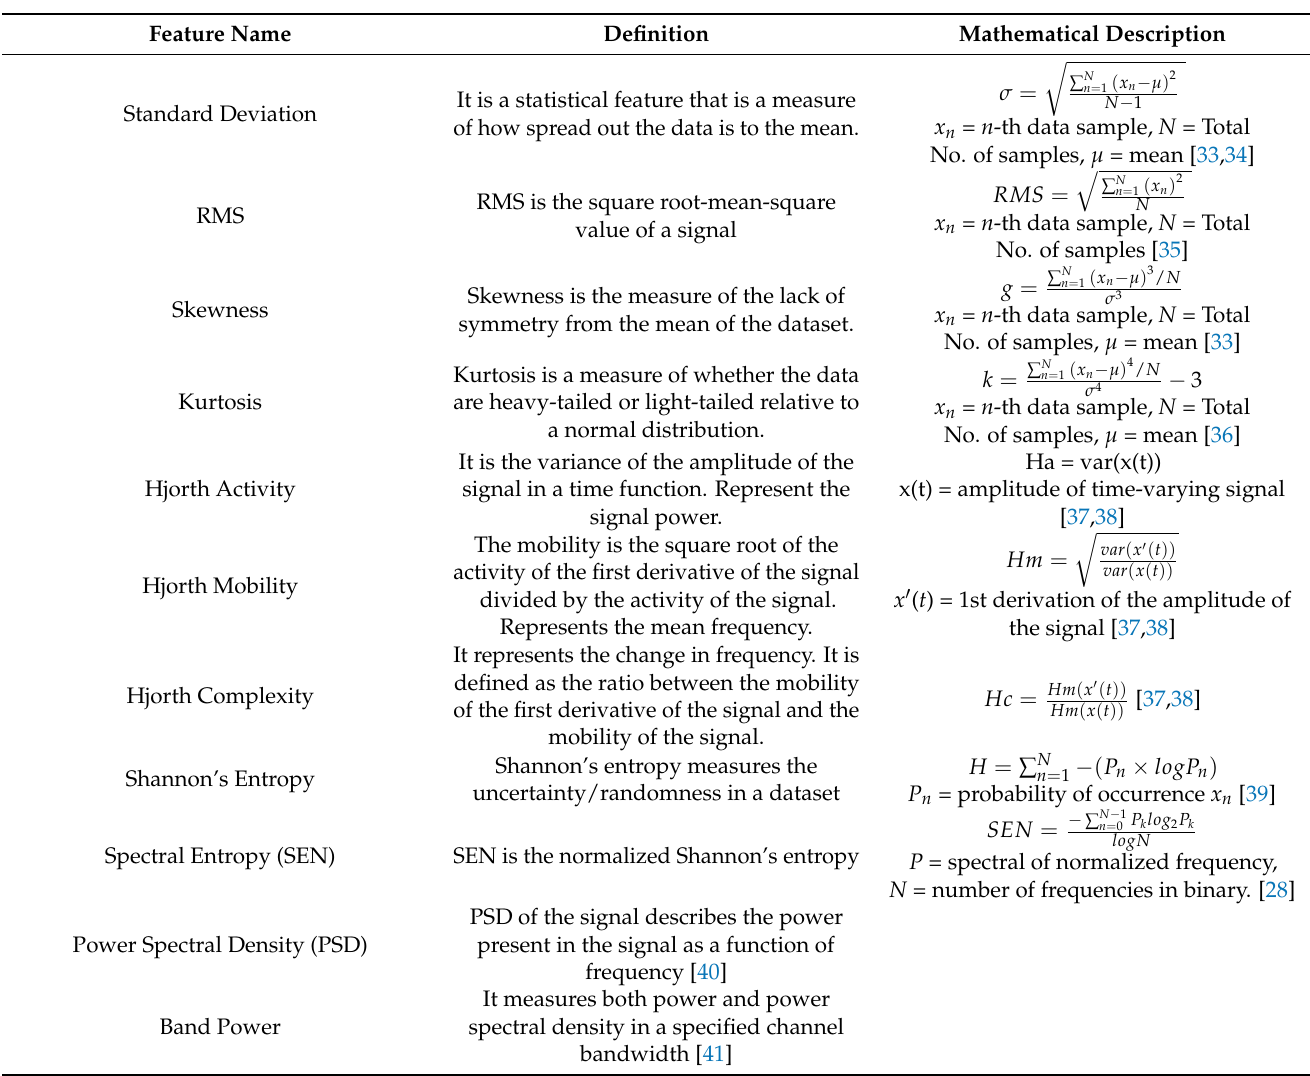
Table 3. Summary of EEG features employed in this